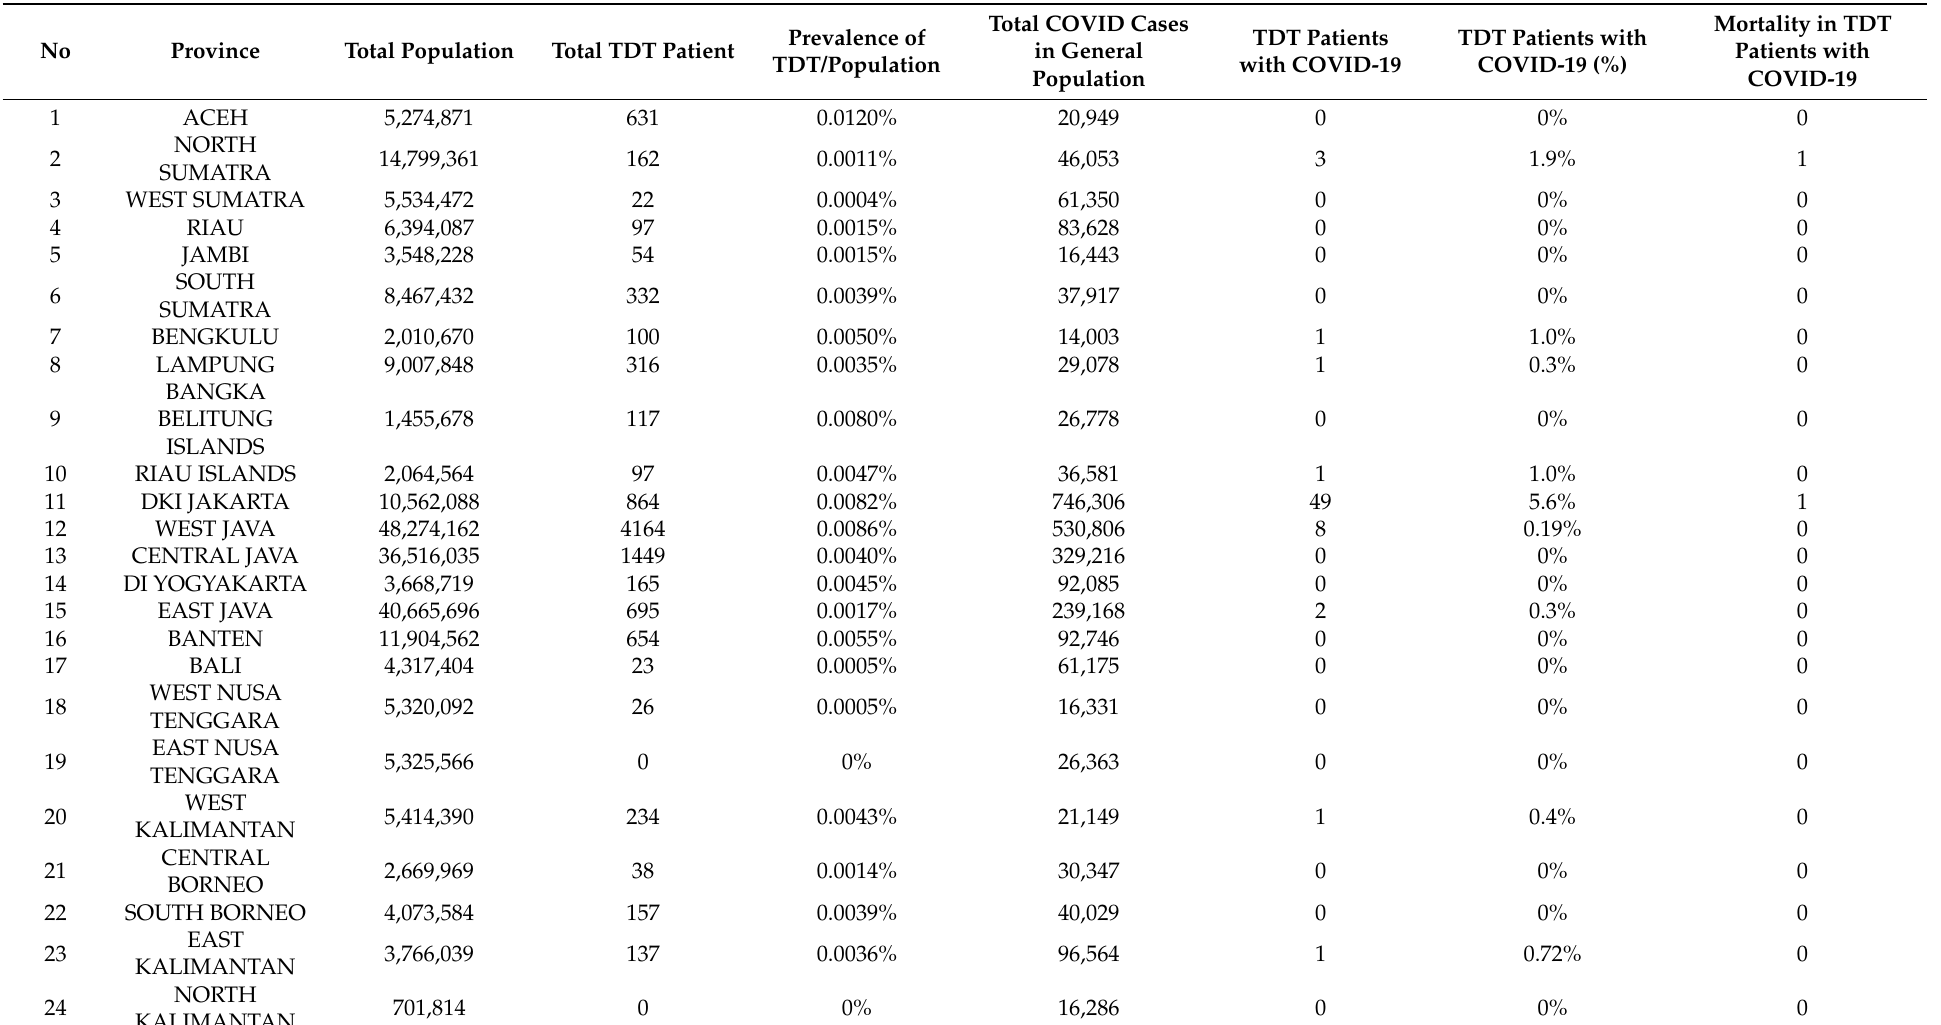
Table 3. Recapitulation of thalassemia in each province and COVID-19 TDT patients